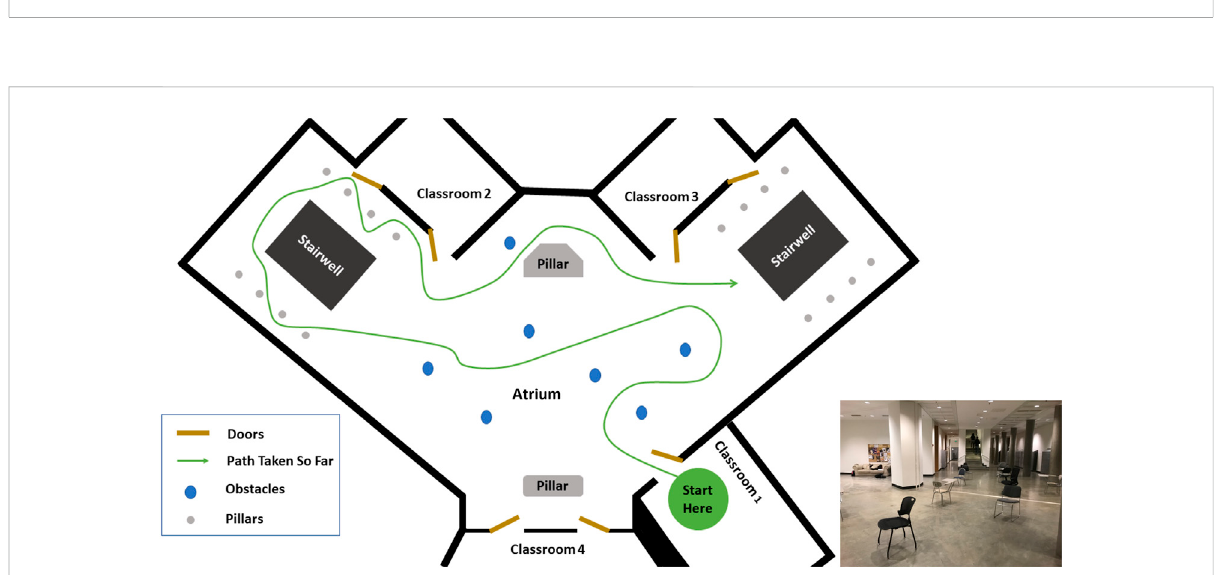
FIGURE 3 Atrium: Architecture of the Atrium. The arrangement of obstacles was not controlled and varies across subjects. The subject walked at self- selected speed and along self-selected path, The experimenter directed the subject to change their path only if the subject repeated the same path more than 2